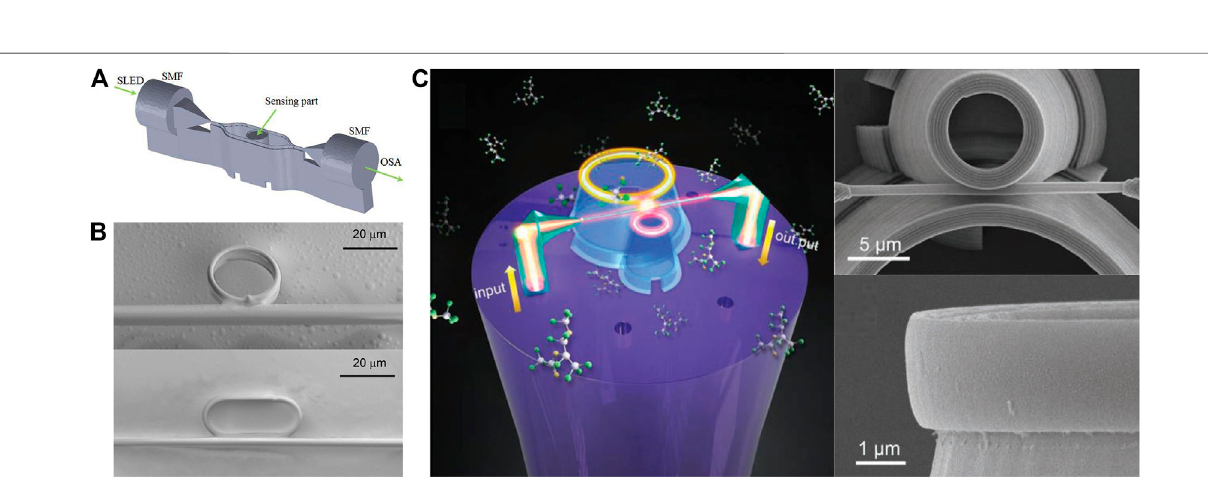
FIGURE 6 | Optical fi ber integrated MZI printed by TPP. (A) Polymer MZI based on seven core fi ber for liquid RI detection (Qi et al., 2017). (B) Opto fl uidic polymer MZI for liquid RI detection (Zhang et al., 2019a).